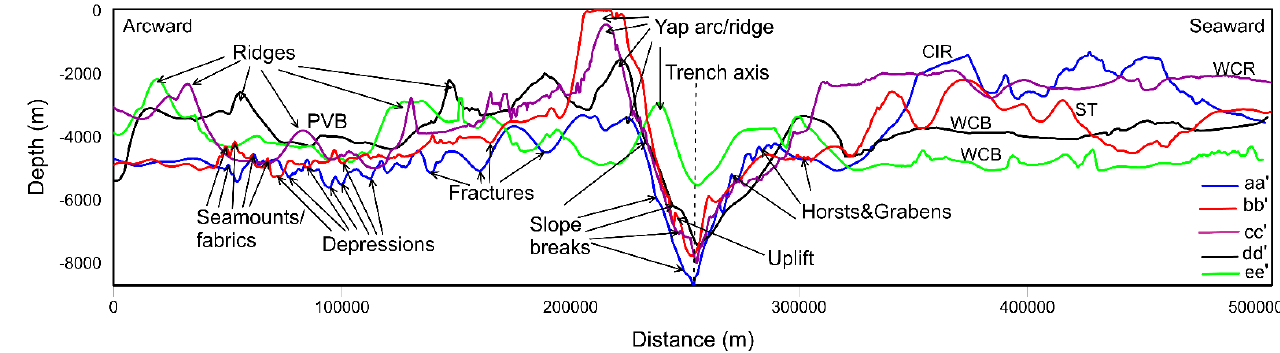
Figure 3. The impact of the CR subduction on the submarine topography of the southernmost Parece Vela Basin, Yap arc, arc-ward trench slope, Yap Trench axis, and sea-ward trench slope in the north and south of 8°26 ′ N. Profiles aa’, bb’, and cc’ are extracted from the line segments aa’, bb’, and cc’ north of 8°26 ′ N, respectively, and profiles dd’ and ee’ are extracted from line segments dd’ and ee’ south of 8°26 ′ N, respectively. See Figure 1 for the location of the line segments, aa’, bb’, cc’, dd’, and ee’, and the abbreviations.